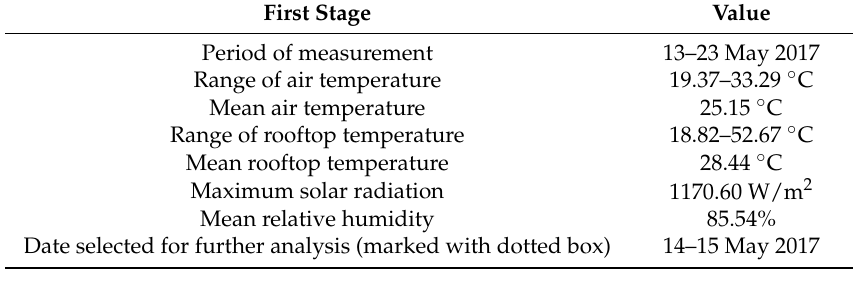
Table 2. Weather data for the first stage (13 May 2017 05:59:44 to 23 May 2017 05:49:44). First Stage